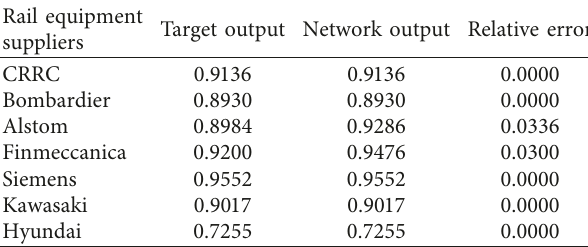
Figure 11: Error of Grey-BPNN model. Table 8: Error of the Grey-BPNN